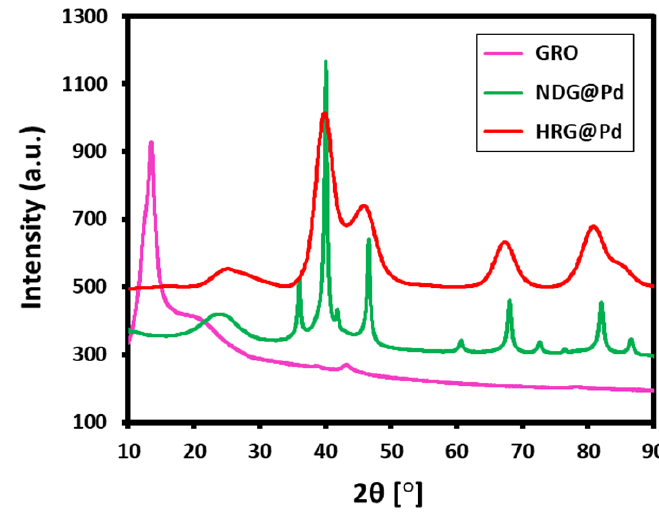
Figure 3. XRD di ff ractogram of graphene oxide (GRO) (pink line), highly reduced graphene-based palladium nanocatalyst (HRG@Pd) (red line), and nitrogen-doped graphene-based palladium nanocatalyst (NDG@Pd) (green line).